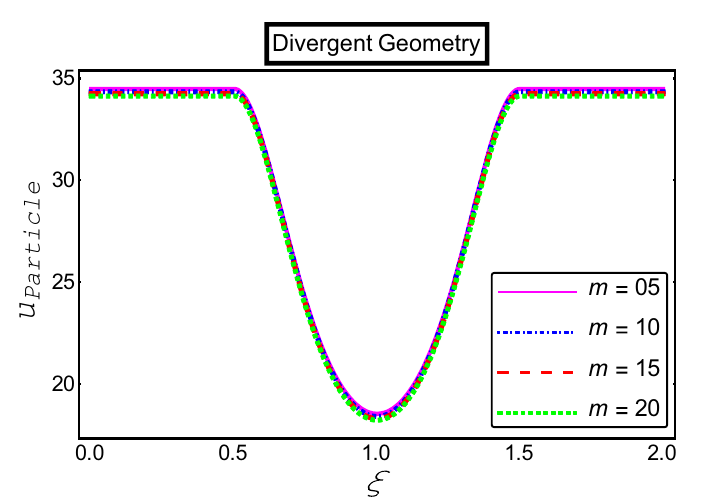
Figure 6. Impact of electro-osmotic parameter on the particle